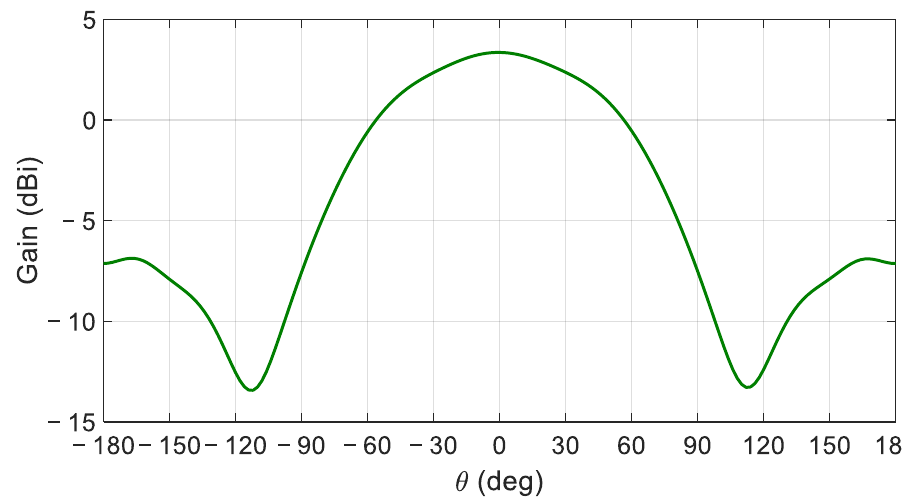
Figure 5. Simulated gain profile for the conventional CDRA design in LTCC at 29.5 GHz.